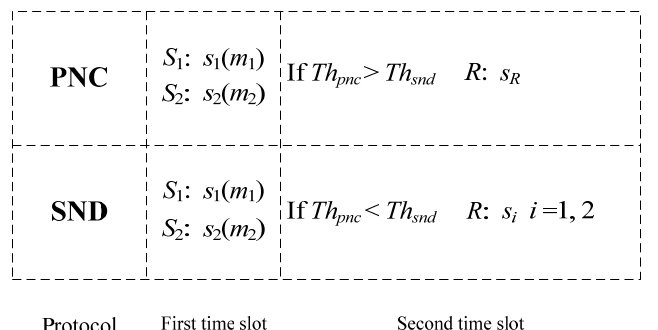
Figure 2. Description of selective PNC protocol. During the first time slot, the satellite source node and the user source node transmit messages S 1 and S 2 , respectively. During the second time slot, the mobile terminal relay broadcast and forward S R in PNC protocol, while broadcast and forward one of S 1 and S 2 , according to the channel coefficient in SND protocol.